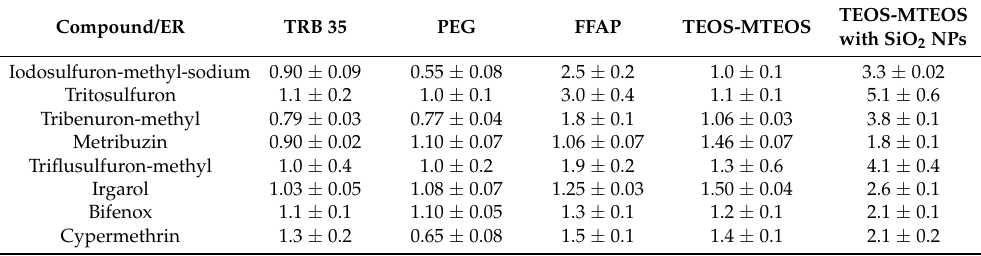
Table 3. Enrichment ratios obtained with respect the TRB 5 capillary columns.